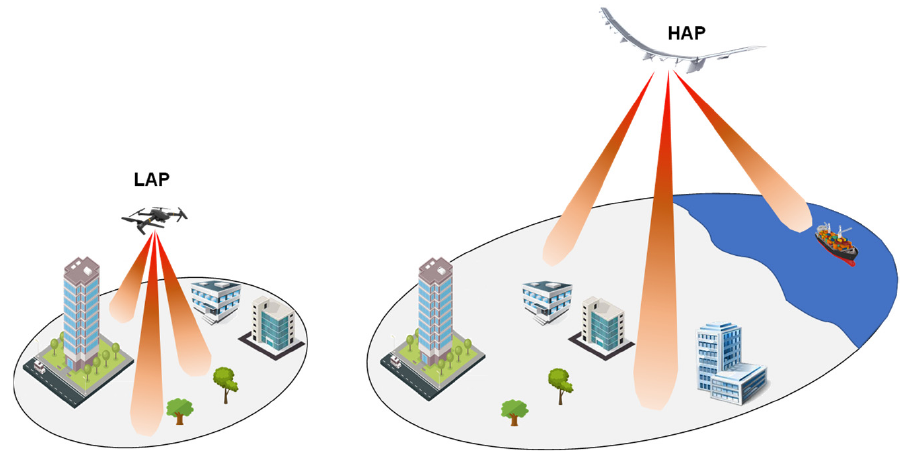
Figure 3. Example of non-hybrid network topology by involving the airborne segment only.